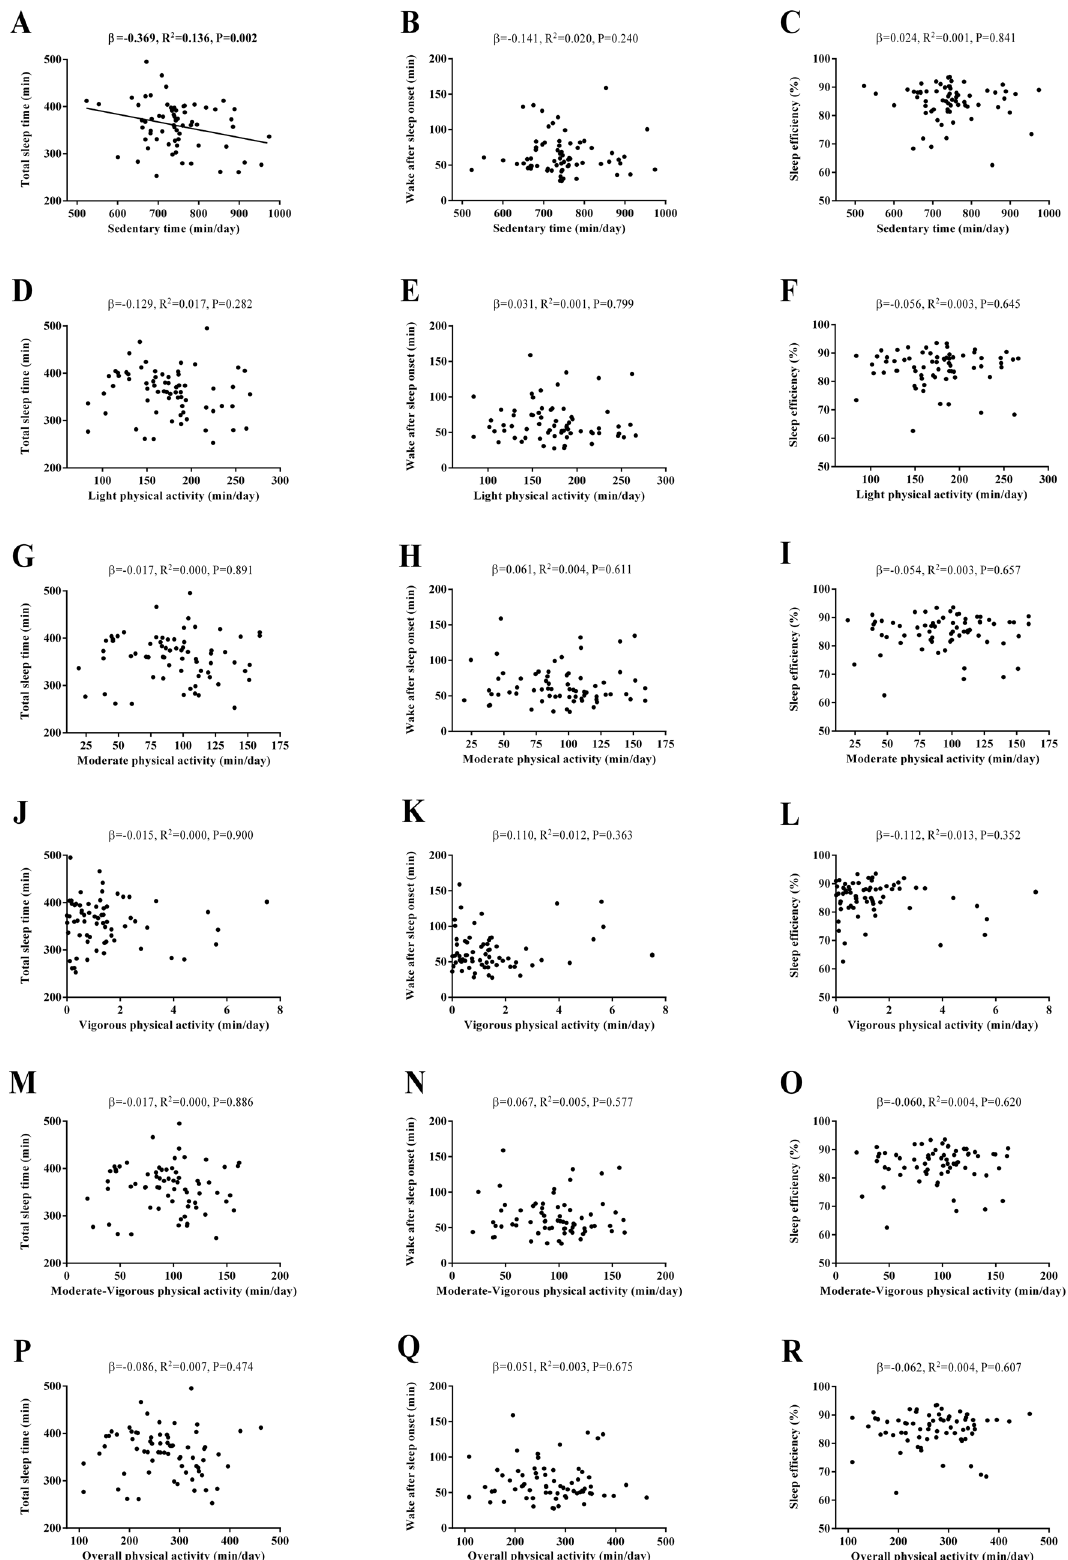
Figure 1. Association of physical activity levels with objective sleep quantity and quality in sedentary middle-aged adults. β (standardized regression coefficient), R 2 , and P from a simple linear regression analysis. Significant P values (≤ 0.05) are in